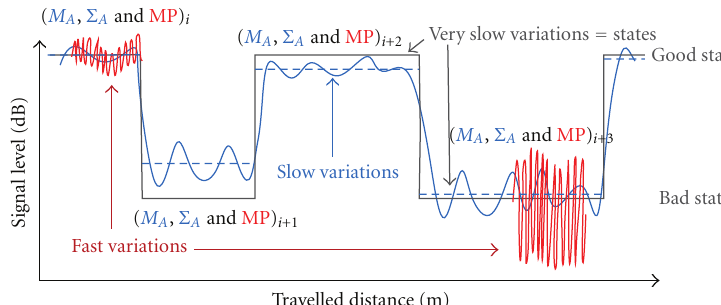
Figure 1: Signal components of a two-state LMS channel